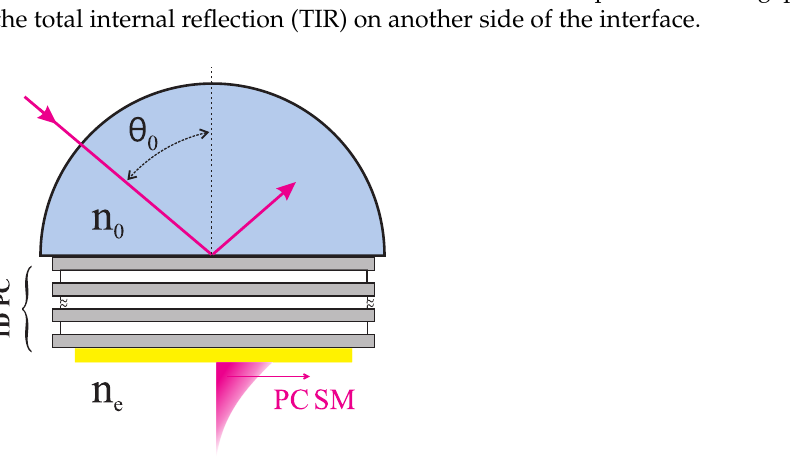
Figure 1. Excitation of optical surface waves in a Kretschmann-like